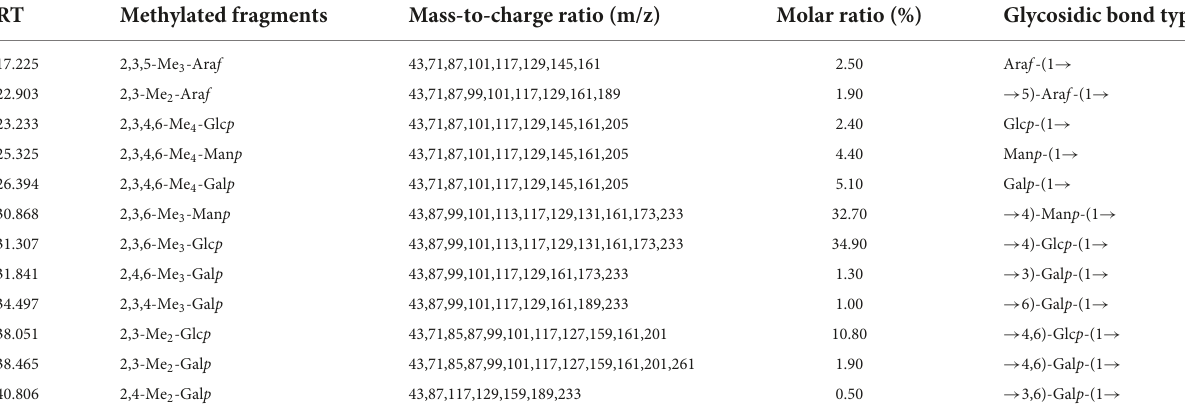
TABLE 3 Analysis of polysaccharide methylated glycol acetates (PMAA) results. RT Methylated fragments Mass-to-charge ratio (m/z) Molar ratio (%) Glycosidic bond